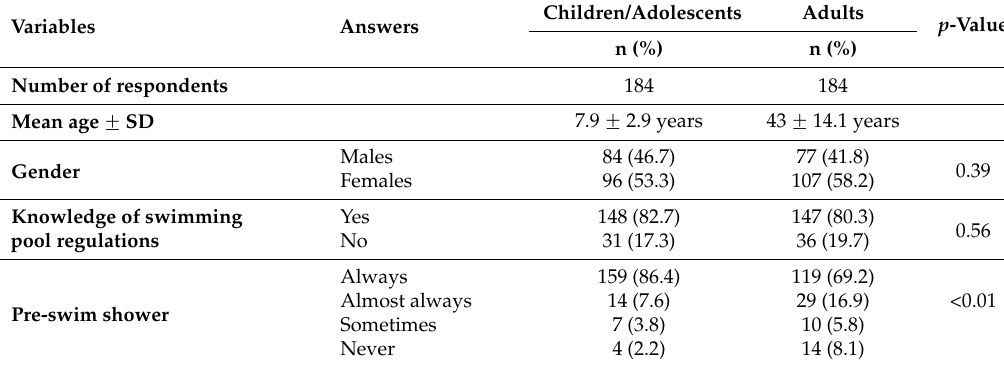
Table 1. Demographic data and declared behaviors of the two groups of bathers with corresponding p